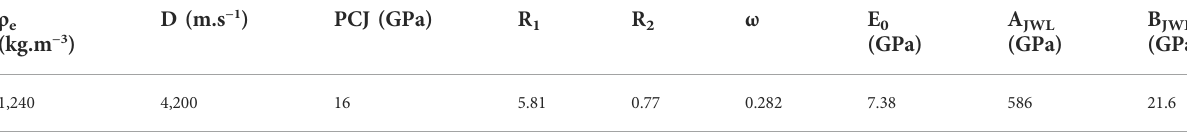
TABLE 4 Parameters for the explosive material and JWL EOS.